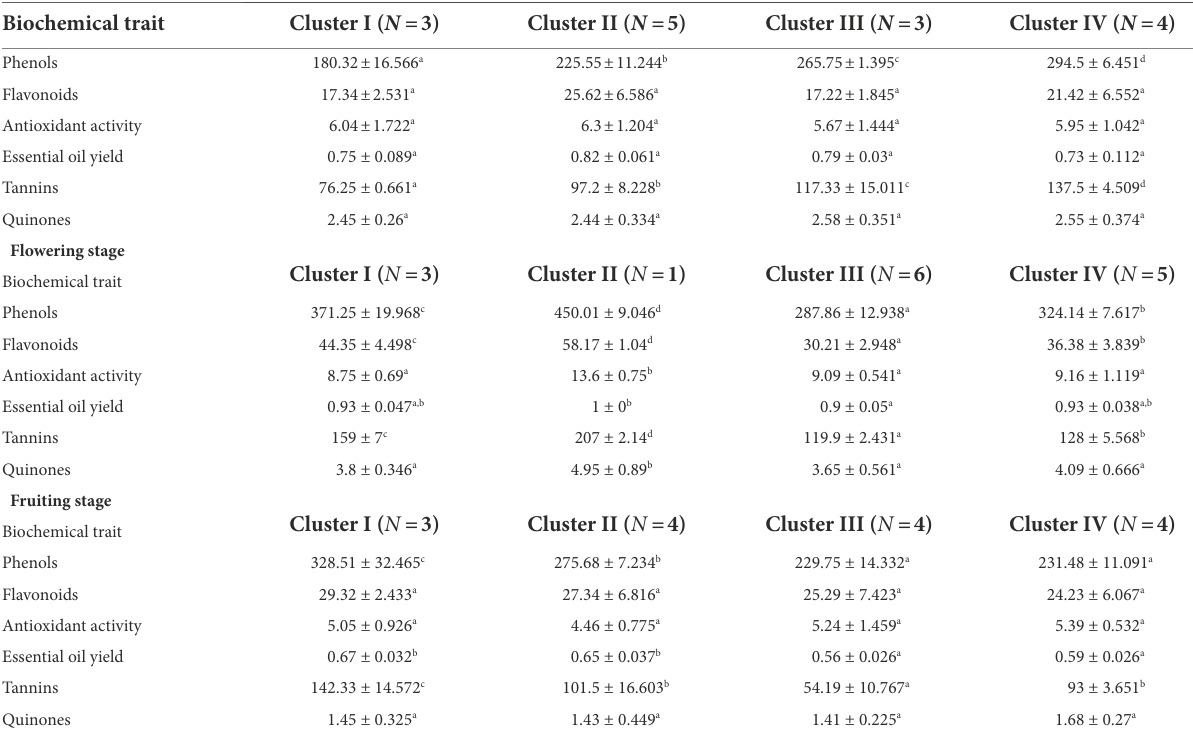
TABLE 2 Mean values of phytochemicals in MK leaves organized into different clusters at each growth